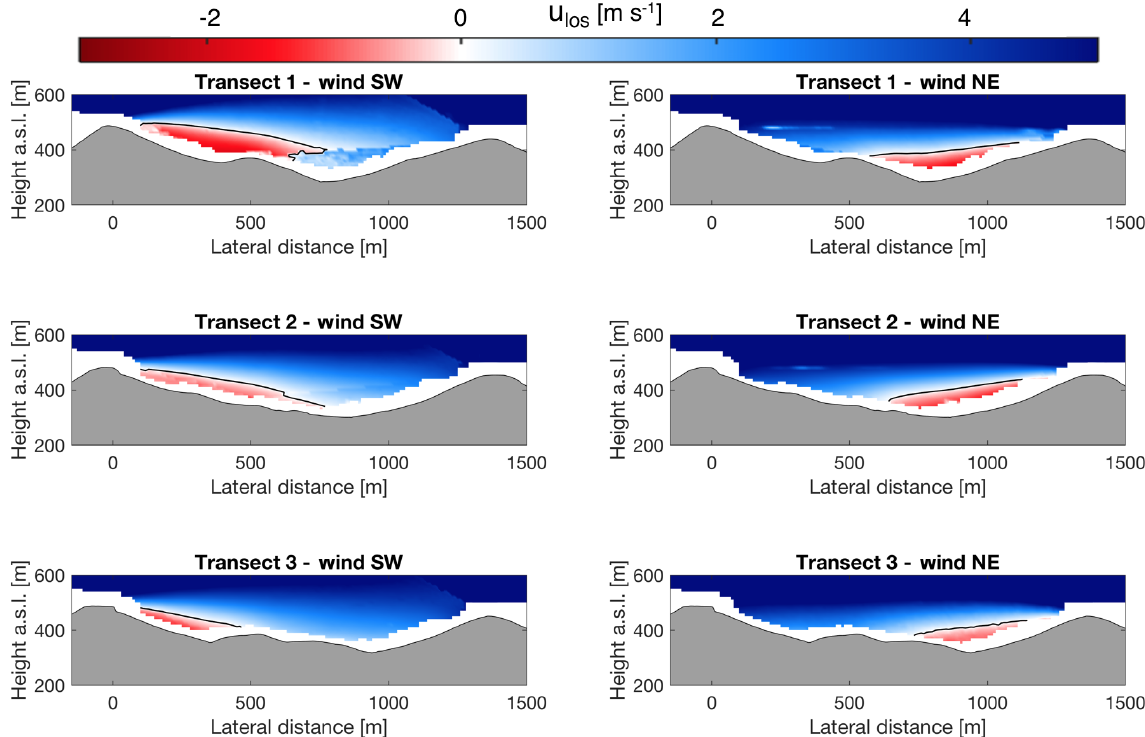
Figure 8. Zero contour line (black line) defining the upper border of recirculation zones of the mean velocity field of all recirculation periods per transect and flow direction. The flow speed is positive in the direction of the mean flow field and the transect origins (lateral distance of 0) refer to the positions of WindScanners 105, 102 and 106 for transects 1, 2 and 3,